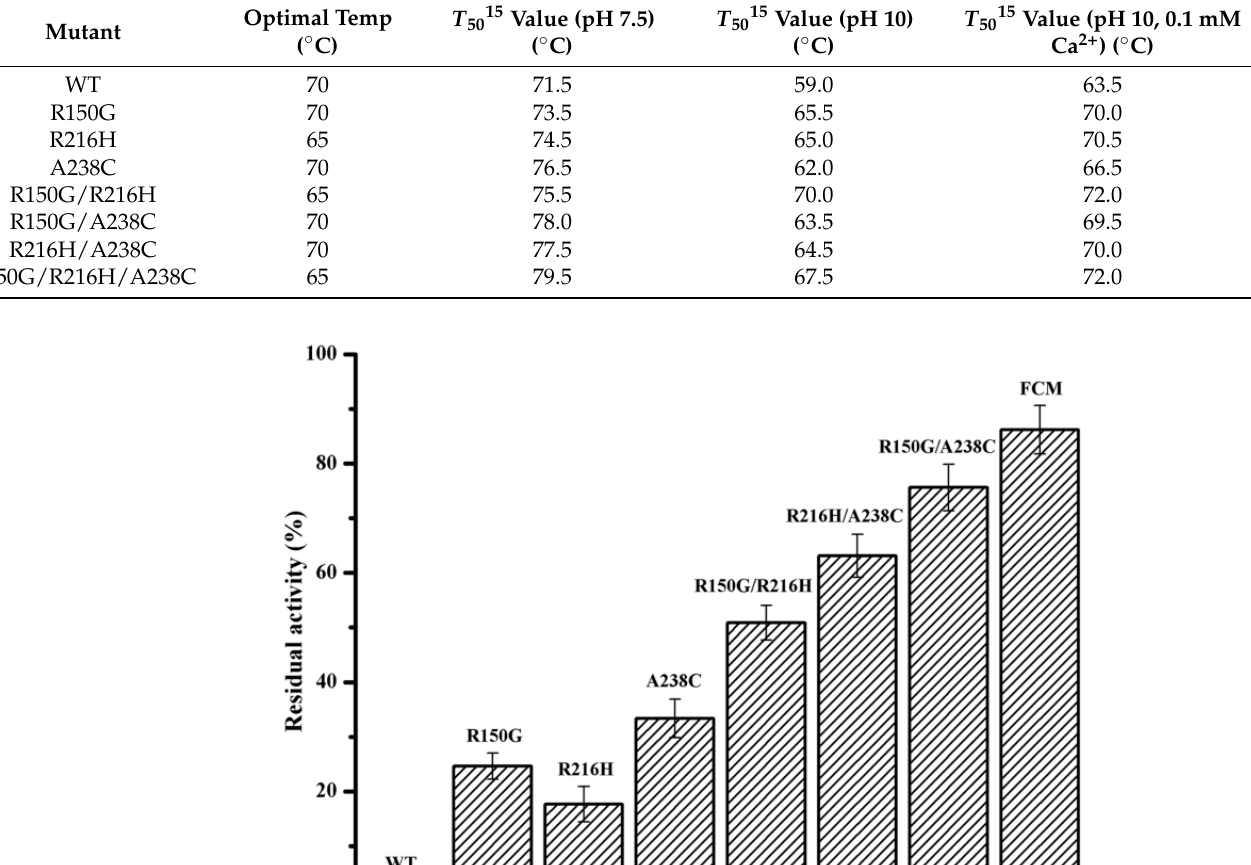
Table 3. Optimal temperature and T 5015 value of the wild-type BacPelA and mutants.